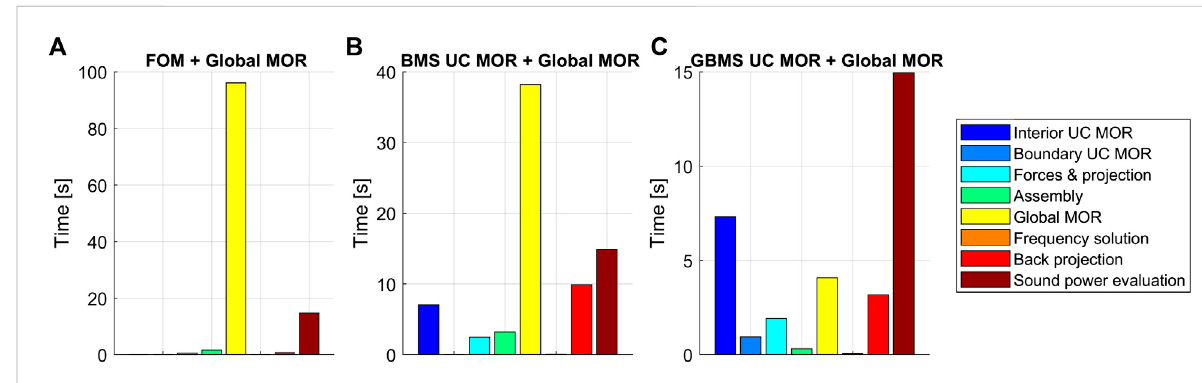
FIGURE 8 Overview of the computation times for theSTL calculations of the clamped fi niteLRM plate assembly of 5× 5UCs for the FOM (A) , BMS (B) and GBMS (C) based UC ROMs, all applying global MOR. The time ranges on the vertical axis differ per case for